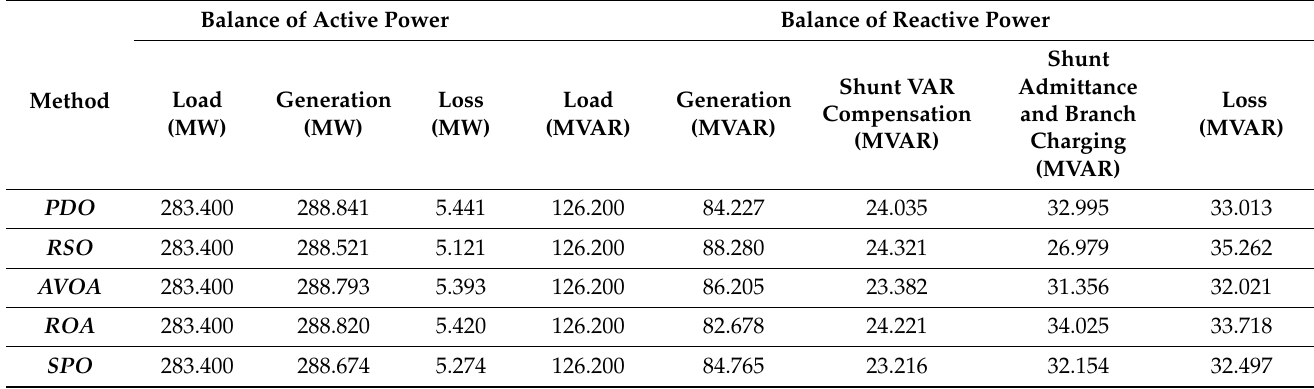
Table 10. Balance of active and reactive power for proposed algorithms with case 2.